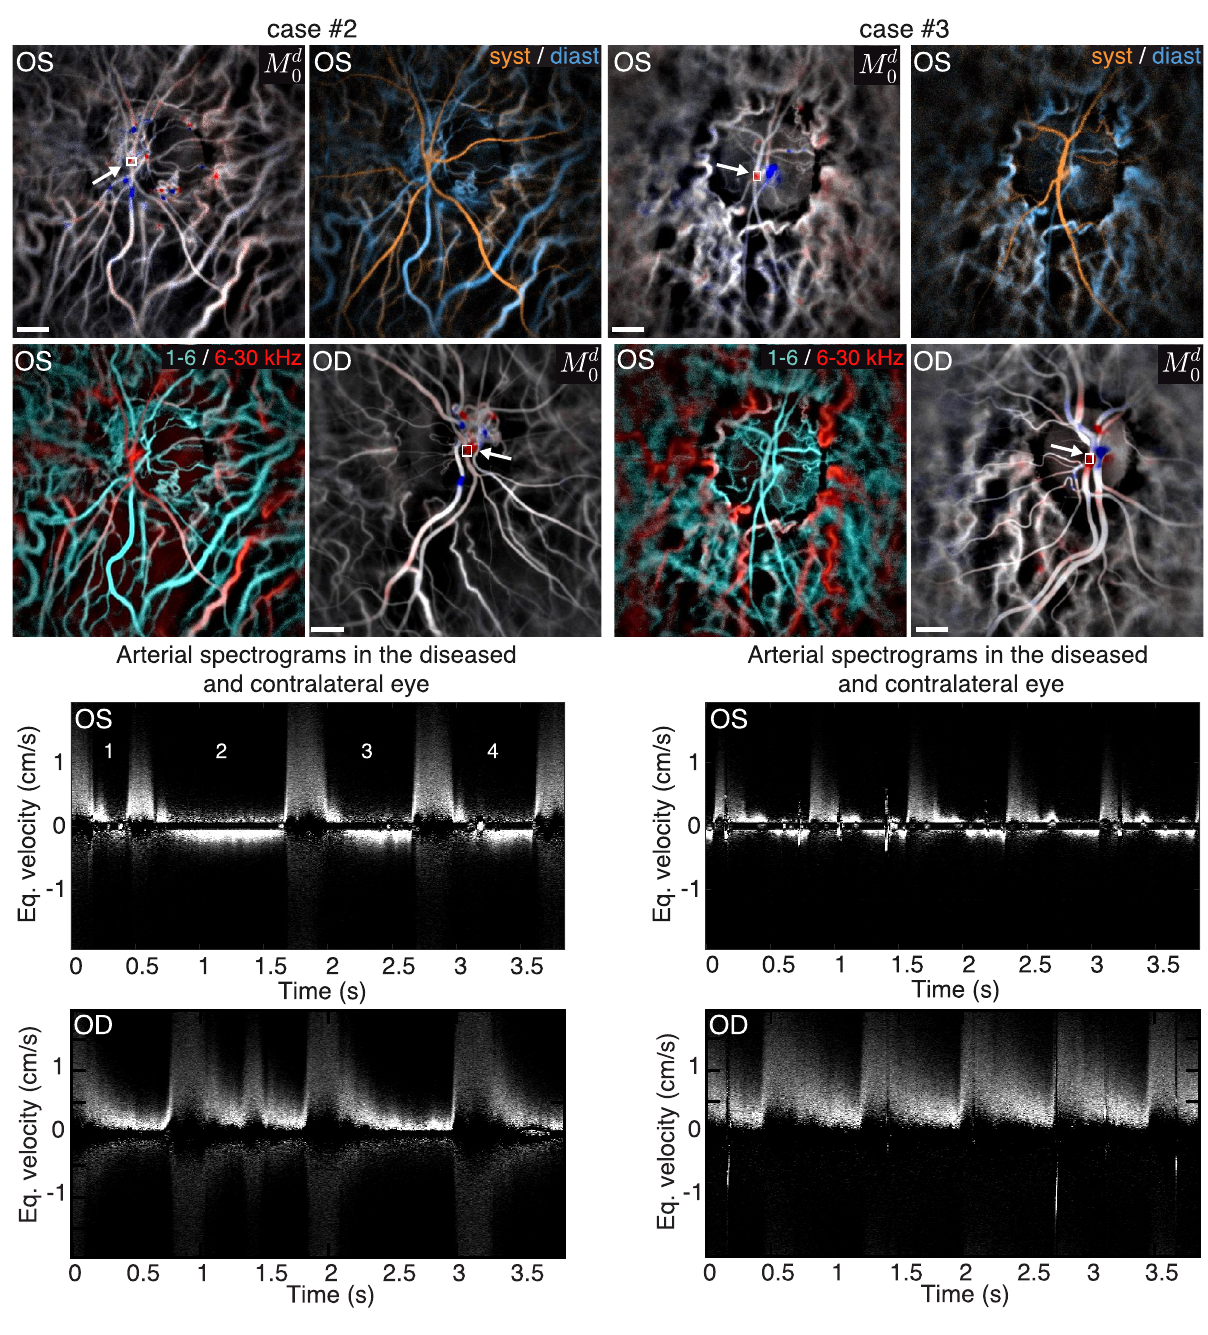
Figure 7. Two other cases of arterial blood flow reversal. On the left is an eye affected by CRVO and glaucoma. On the right is a case of retinal vasculitis. For each case the color composite systolodiastolic and slow/fast flow images, and the directional power Doppler image are shown for the affected left eye (OS). The spectrogram measured in the emergence of the central retinal artery is shown for each case. The directional power Doppler and the arterial spectrograms are also shown for the contralateral right eye (OD). For both cases, the pathological increased vascular resistance causes a reflow. Visualization 5 and Visualization 6 show the directional blood flow movies juxtaposed to the spectrograms for the two eyes of both subjects. The estimated size of the scale bar is 500 µ